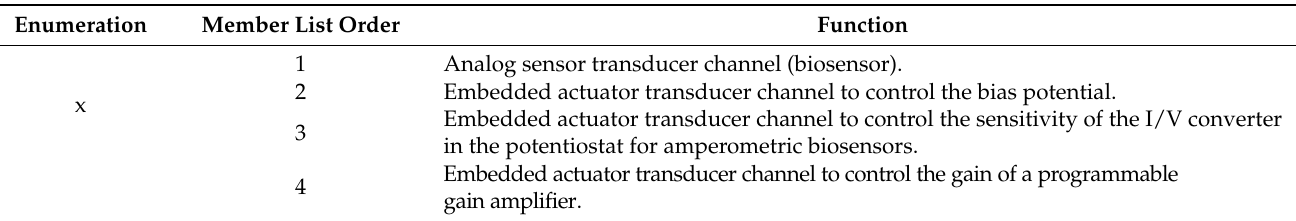
Table 3. Proposed control group for representing a transducer.